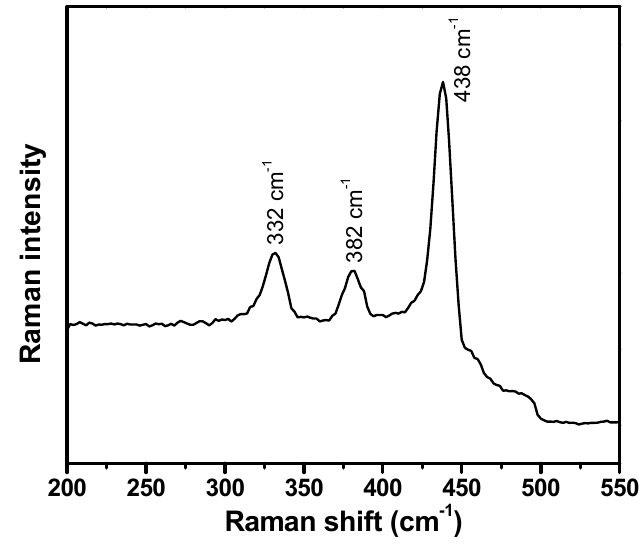
Figure 4. Raman spectrum for hydrothermally synthesized ZnO nanoballs.